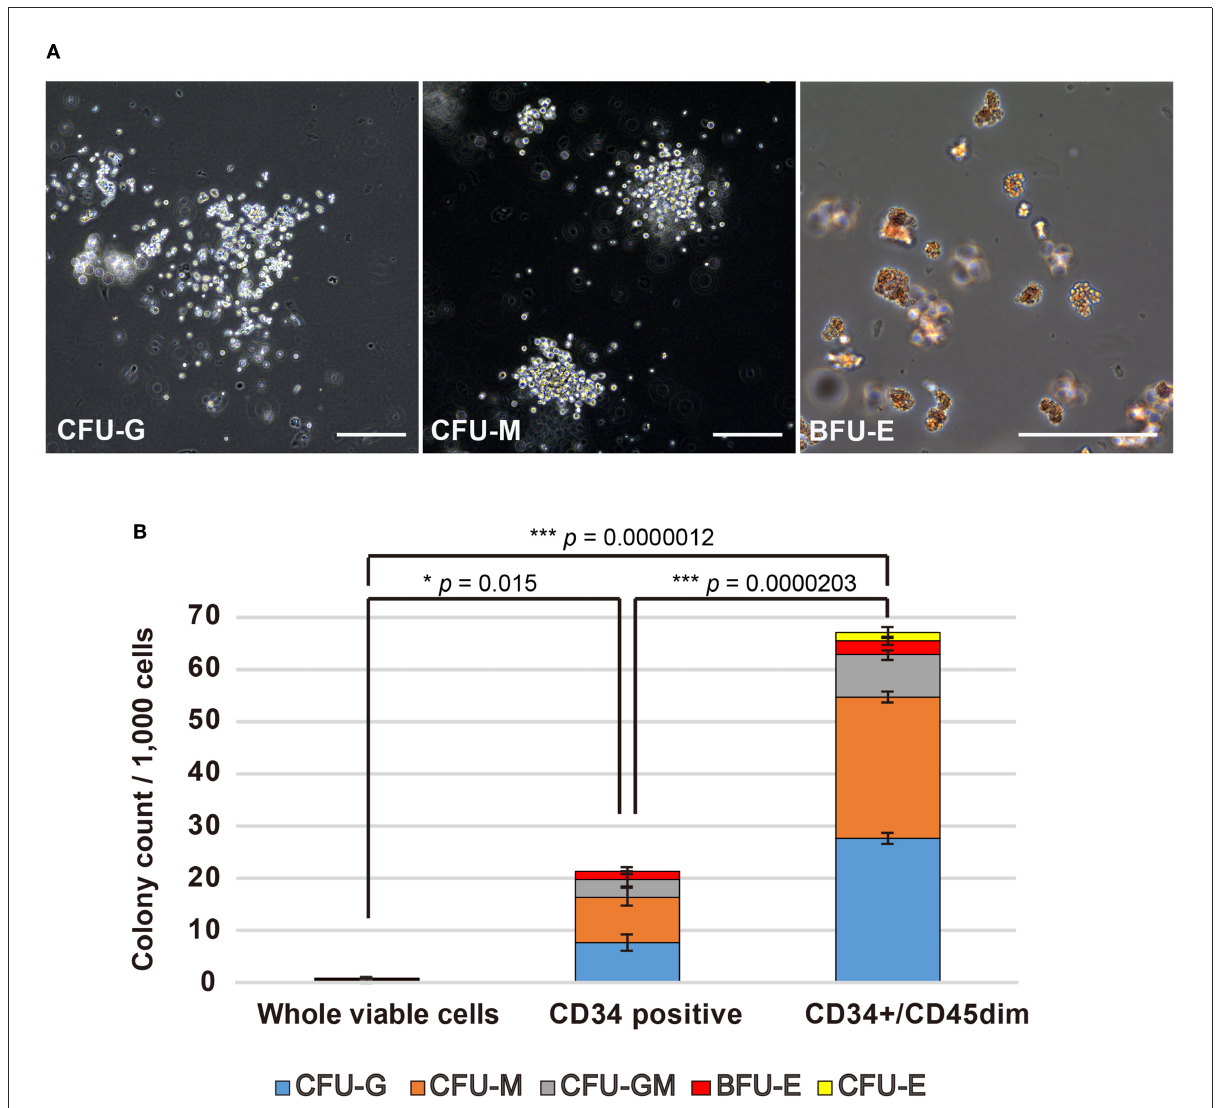
FIGURE2 Haematopoietic colony formation by canine haematopoietic stem and progenitor cells (HSPCs). (A) Microscopic observation of canine haematopoietic colonies (Scale bars: 200 µ m). (B) Haematopoietic colonies for every 1,000 cells, as counted for whole viable cells, CD34 + cells, and CD34 + /CD45diminished (CD45 dim ) cells. Experiments were performed four times independently. Results are presented as mean ± standard error of the mean (SEM). Statistical significance of total colony counts was assessed by one-way analysis of variance (ANOVA). * p < 0.05, *** p <